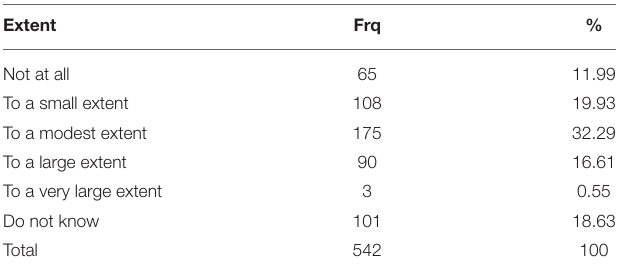
TABLE 5 | Pastoralist household perception of their ability to respond to their